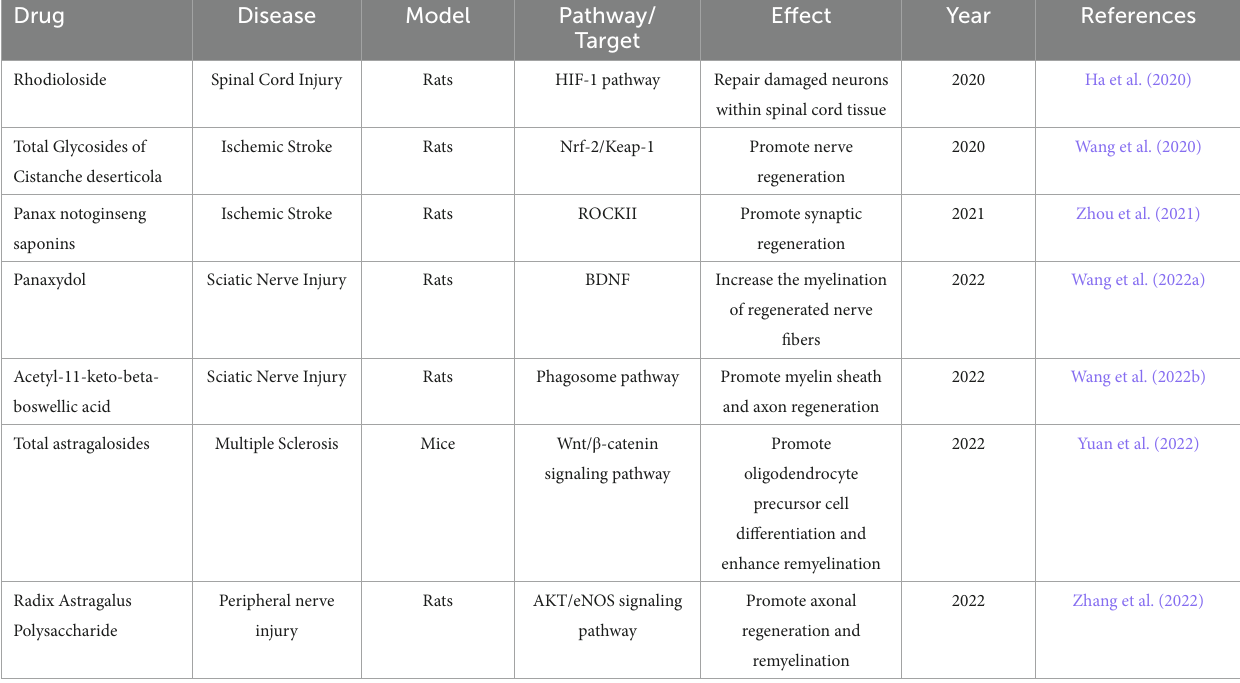
TABLE 1 Herbal drugs that promote nerve regeneration through other